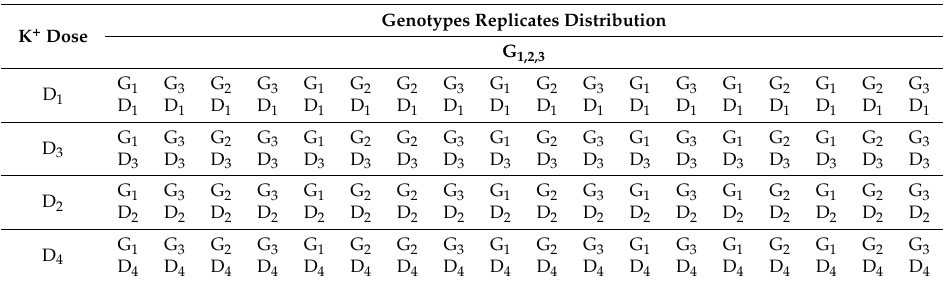
Table 1. Factorial experiment in a randomized blocks design ( n = 72). Genotypes Replicates Distribution K + Dose